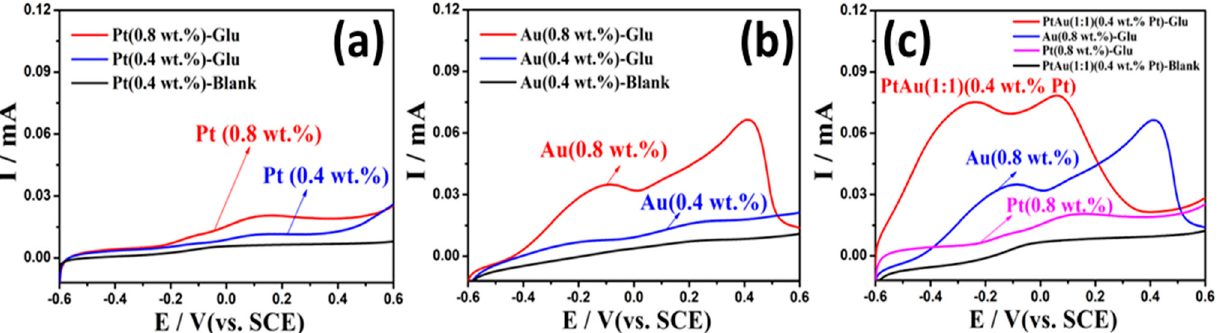
Figure 11. LSV measurements of the ( a ) Pt/C, ( b ) Au/C, and ( c ) PtAu (1:1)/C in 0.08 M NaOH with absence (black curve) and presence (blue, red, and pink curves) of 10 mM glucose. (Reproduced with permission from [229]. Copyright Elsevier, 2015).